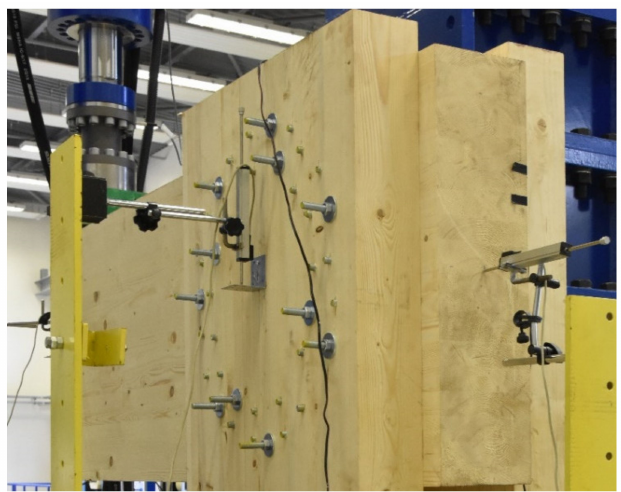
Figure 18. Placement of the deformation sensors.